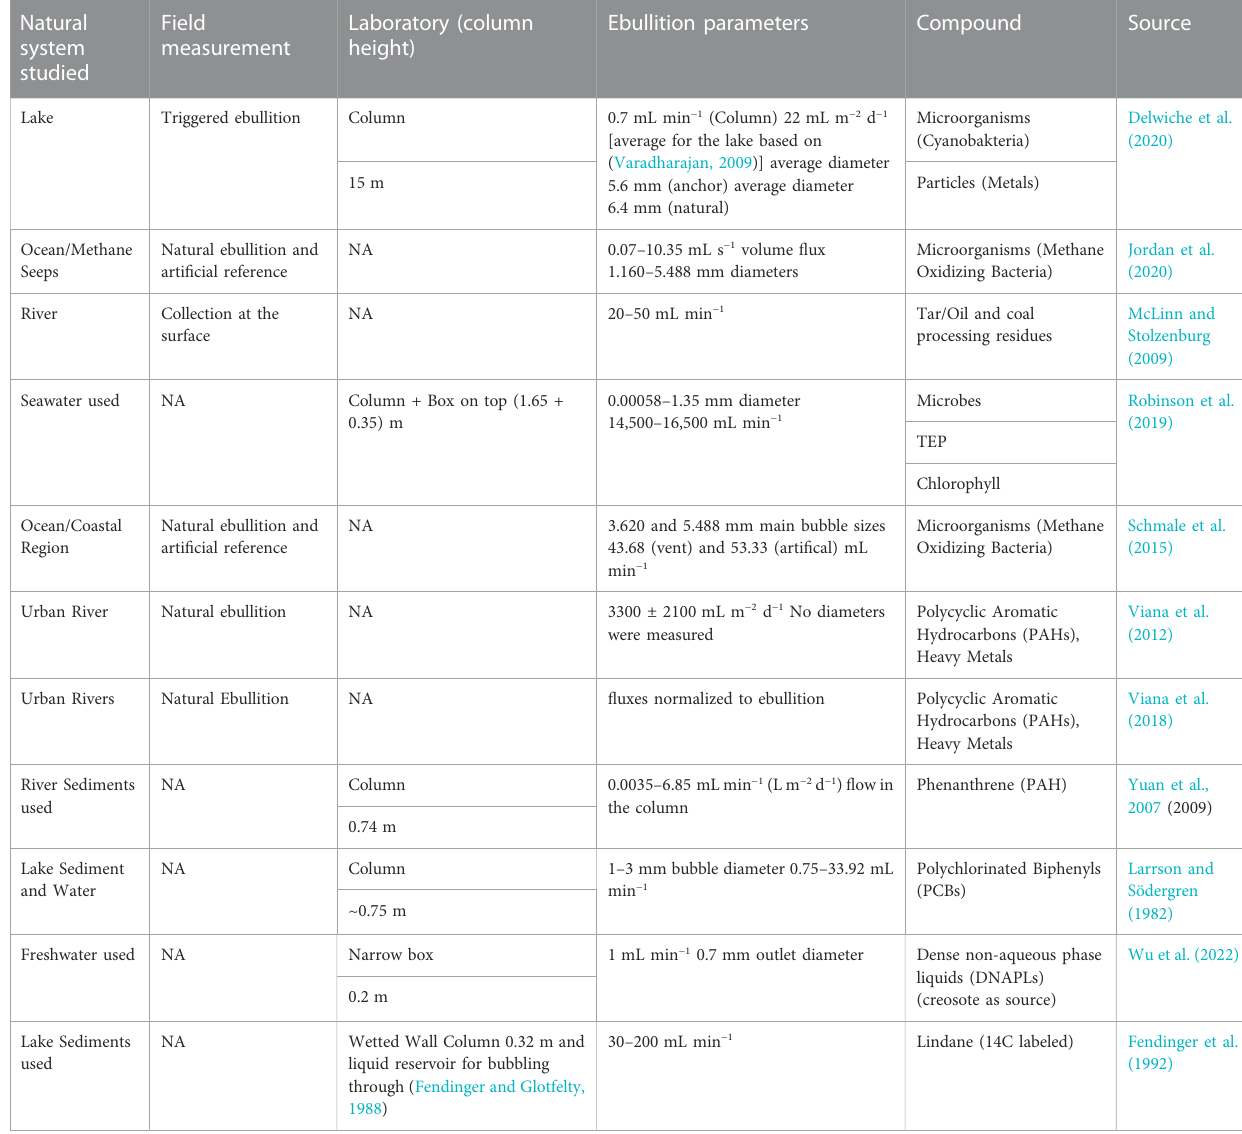
TABLE 1 Previous works examining bubble-mediated transport of solutes and particles by bubbles released from aquatic sediments in fi eld and in laboratory settings. Natural